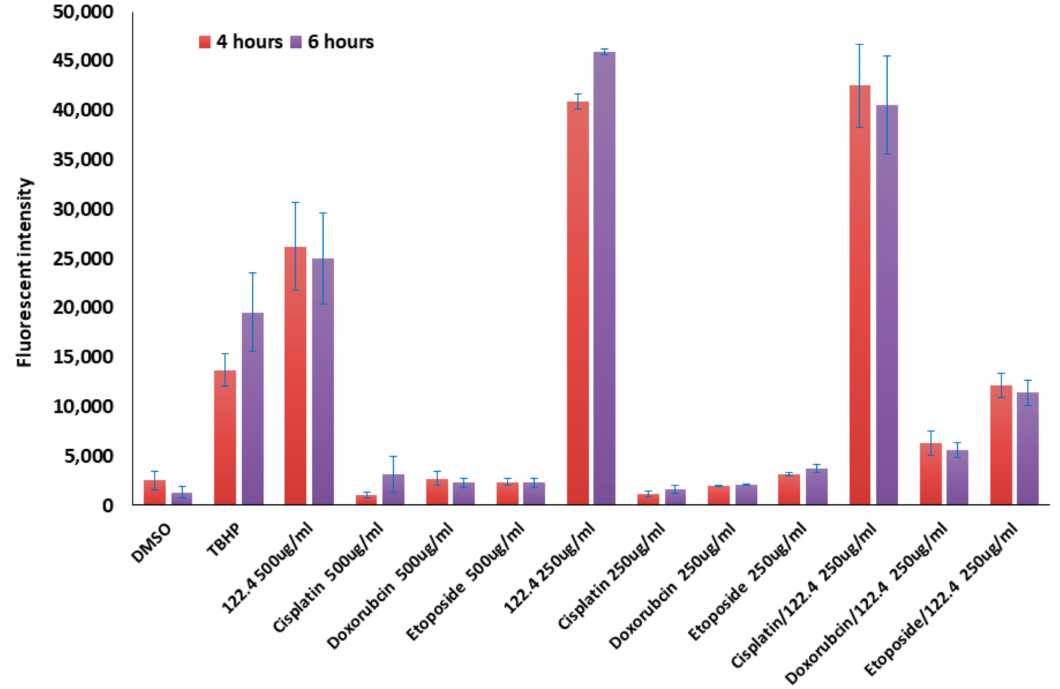
Figure 5. The effect of 122.4 on ROS production in BS-24-1 in combined treatments. 5 × 10 5 cells/well were treated with 250–500 µ g/mL in a single treatment assay and with 250 µ g/mL of both 122.4 and chemotherapeutic drugs in the combined treatment assay. X -axis represents the different treatments. Y-axis represents fluorescence intensity (ROS